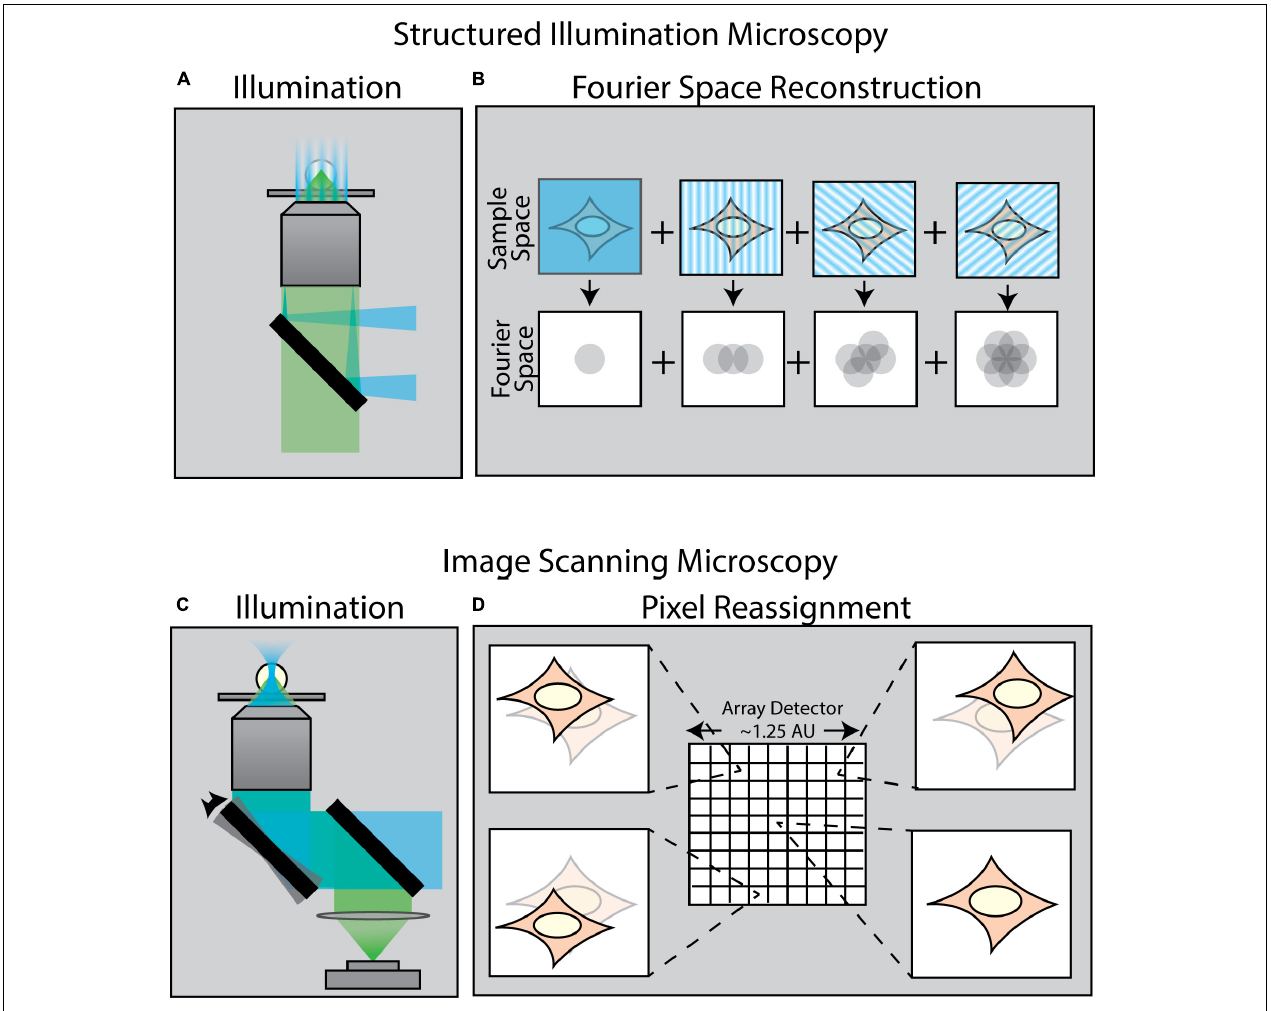
FIGURE 2 | Methods of enhancing resolution in optical microscopy. (A) Structured Illumination Microscopy (SIM) is a widefield technique capable of up to twofold resolution enhancement in all directions. It relies on projecting a sinusoidal illumination pattern onto the sample to generate Moiré interference. (B) The illumination pattern is rotated and shifted over a series of 9–15 images to introduce extended frequency information into the Fourier space of the image. (C) Image Scanning Microscopy (ISM) uses an illumination scheme identical to laser-scanning confocal microscopy; however, the scanned image is collected by an array detector in which each pixel in the array acts as an individual pinhole-restricted point detector. (D) In contrast to confocal microscopy wherein a single image is formed via a single point detector, each pixel in an ISM array detector captures its own unique image of the sample from a slightly different angle. This information is computationally combined to create an enhanced resolution